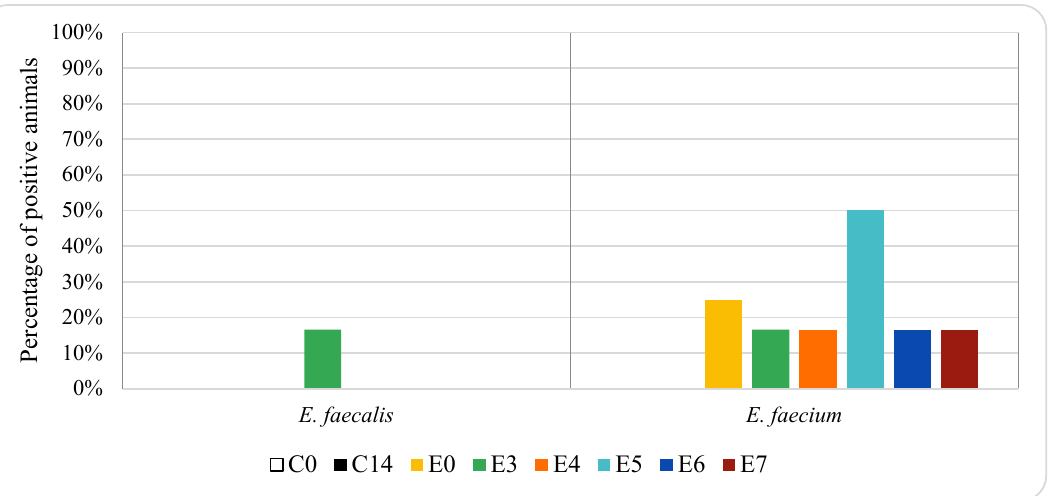
Figure 3. Effect of oxytetracycline treatment on vancomycin-resistant enterococci in pig genital sam- ples. For group descriptions C0, C14, T0, T6, T13, T15, T17 and T19: see Table 1.